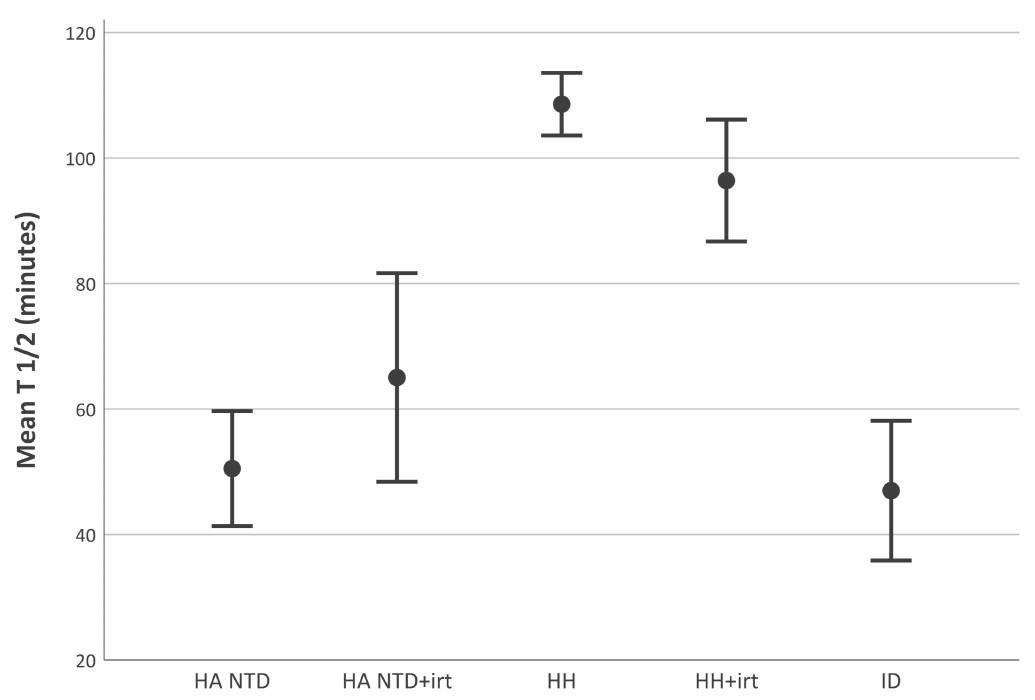
Figure 1. Disappearance half-life of transferrin-bound iron. Disappearance half-life of iron was calculated from blood samples taken at 0, 5, 15, 30, 45, 60, 90 and 120 min after injection. Half-life is expressed in minutes. Plot of the mean half-life categorized per disease group. Error bars represent 95% confidence intervals. HA NTD hereditary anemia, non-transfusion dependent; HH hereditary hemochromatosis; irt iron reducing therapy (phlebotomies or deferoxamine); ID iron deficiency; T 1 half-life; min